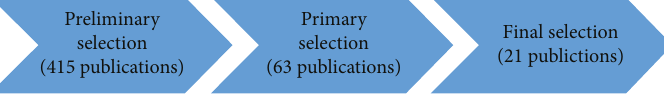
Figure 1: Publication selection Table 4: Codes used in the data consolidation table.